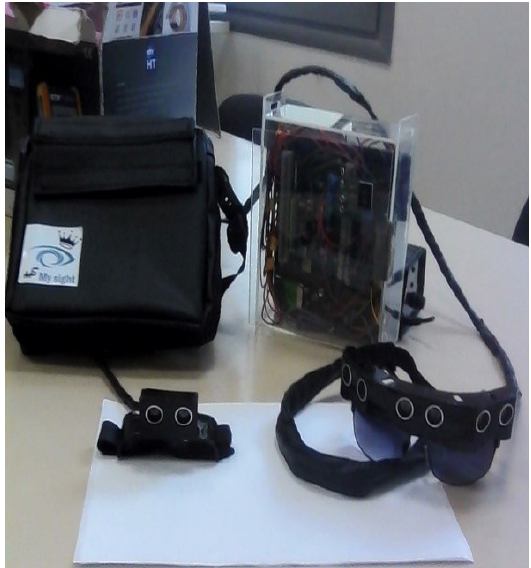
Figure 1. The different components of the designed